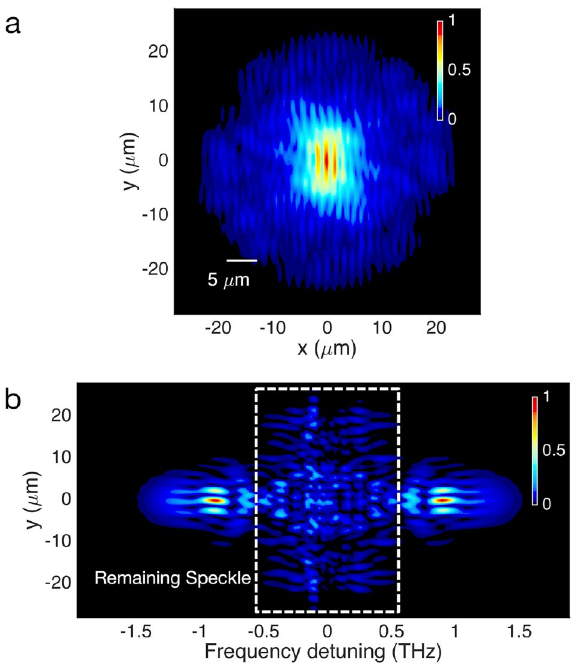
Figure 3. Numerical simulation of interferences between self-cleaned beams obtained from two different MMFs. ( a ) Time-averaged 2D interference pattern, numerically generated from two independent self-cleaned beams, and considering a linear polarization filtering. ( b ) Corresponding 1D interference pattern, projected as a function of frequency detuning from the